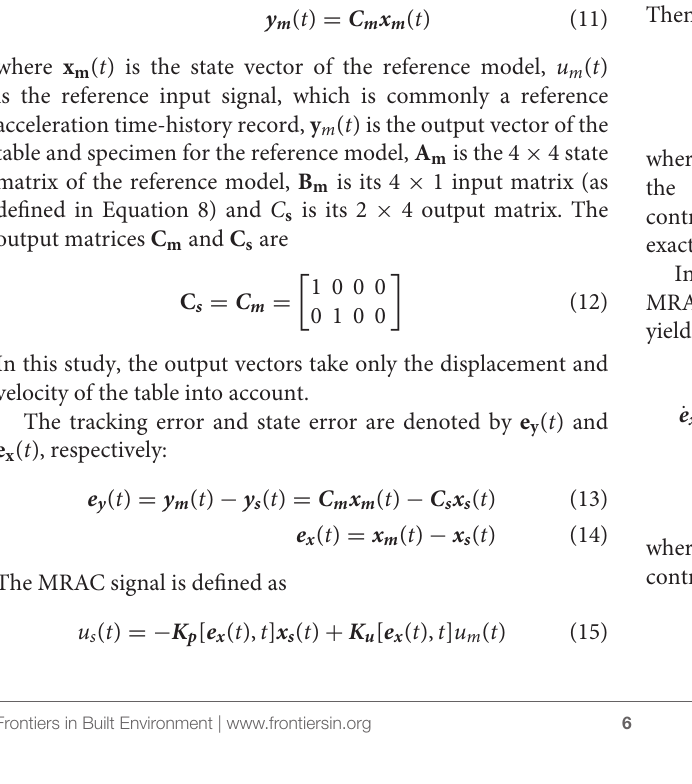
plant, A s is the 4 × 4 state matrix of the controlled plant, B s is its 4 × 1 input matrix, and C s is its 2 × 4 output